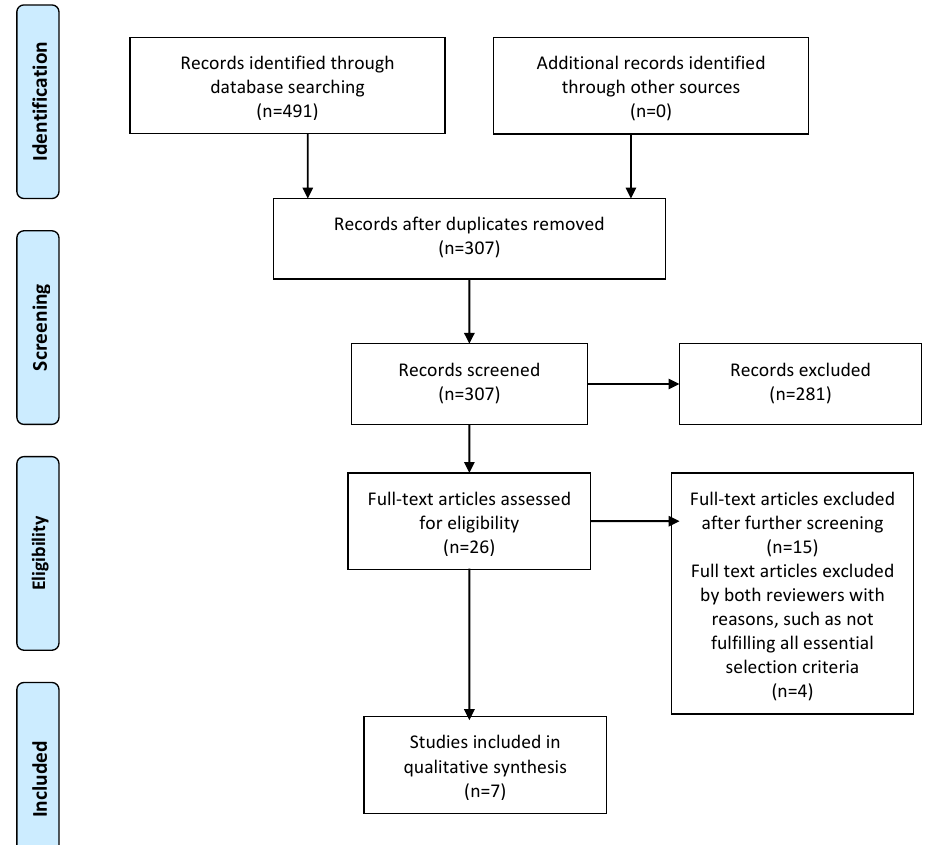
Figure 1. PRISMA flowchart of the search for peer-reviewed journal articles.